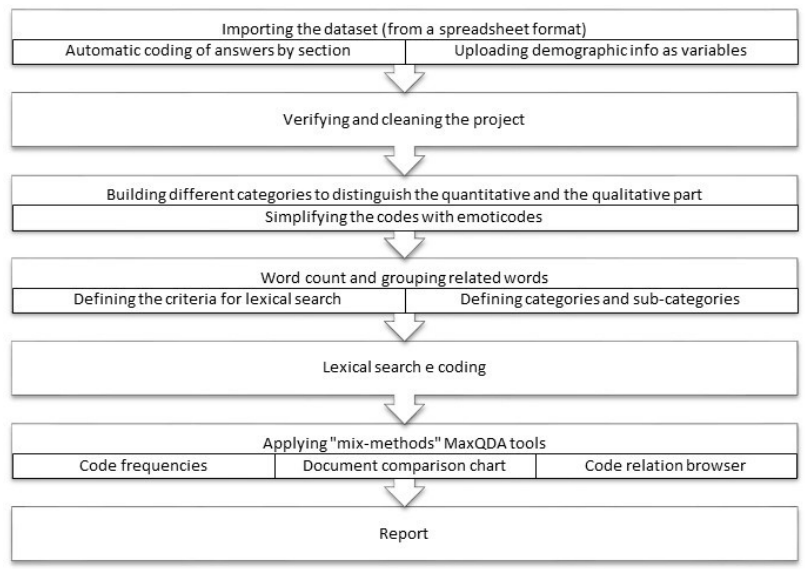
Figure 1. B3 qualitative data analysis strategy.